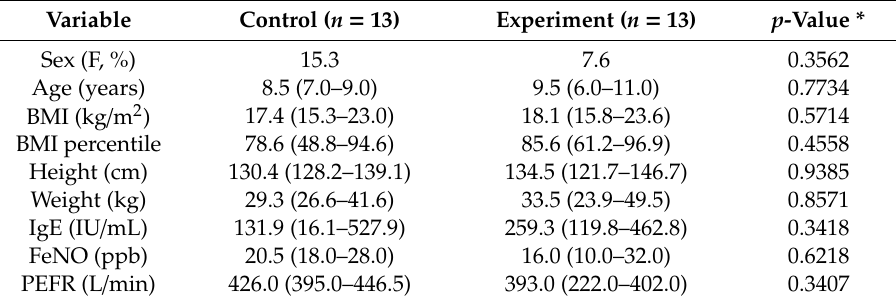
Table 1. Baseline (first day) demographic and clinical information (median